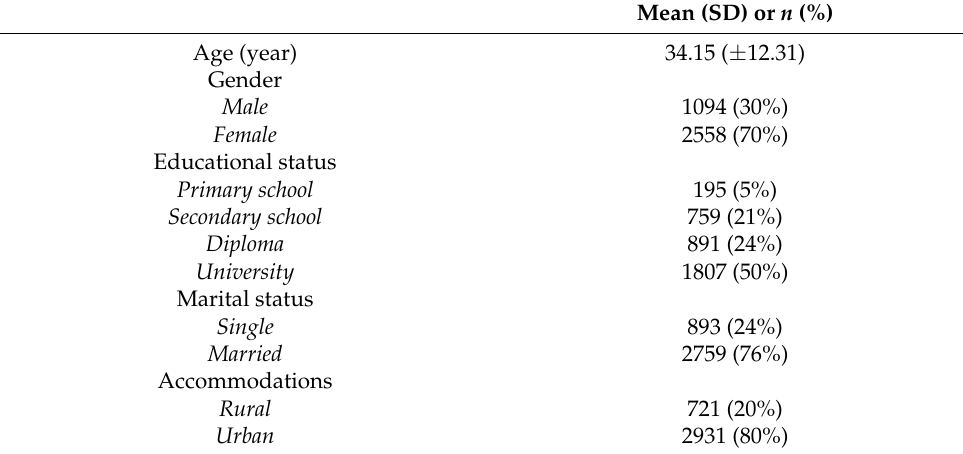
Table 1. Participants’ sociodemographic characteristics (n =